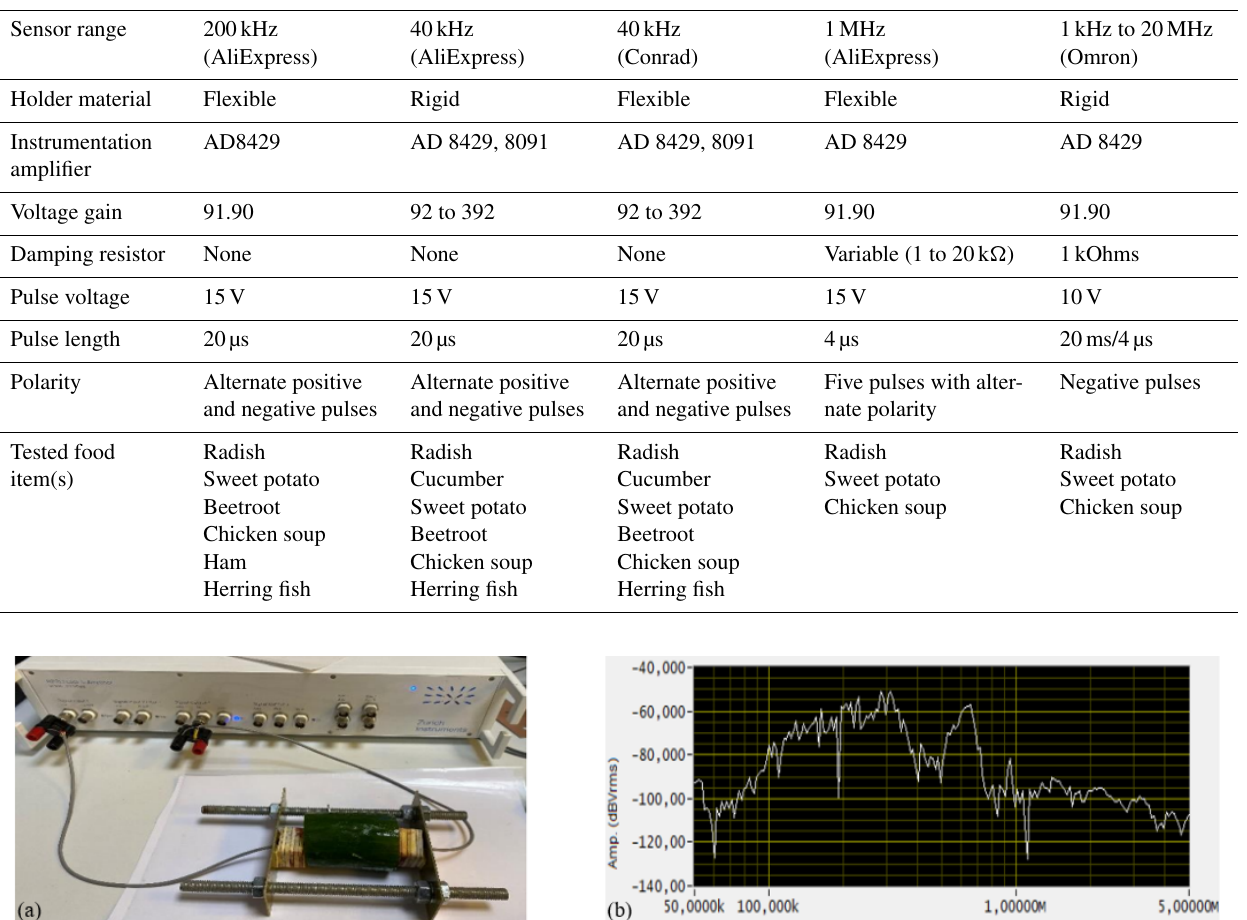
Table 1. Electronic system – design and specifications.